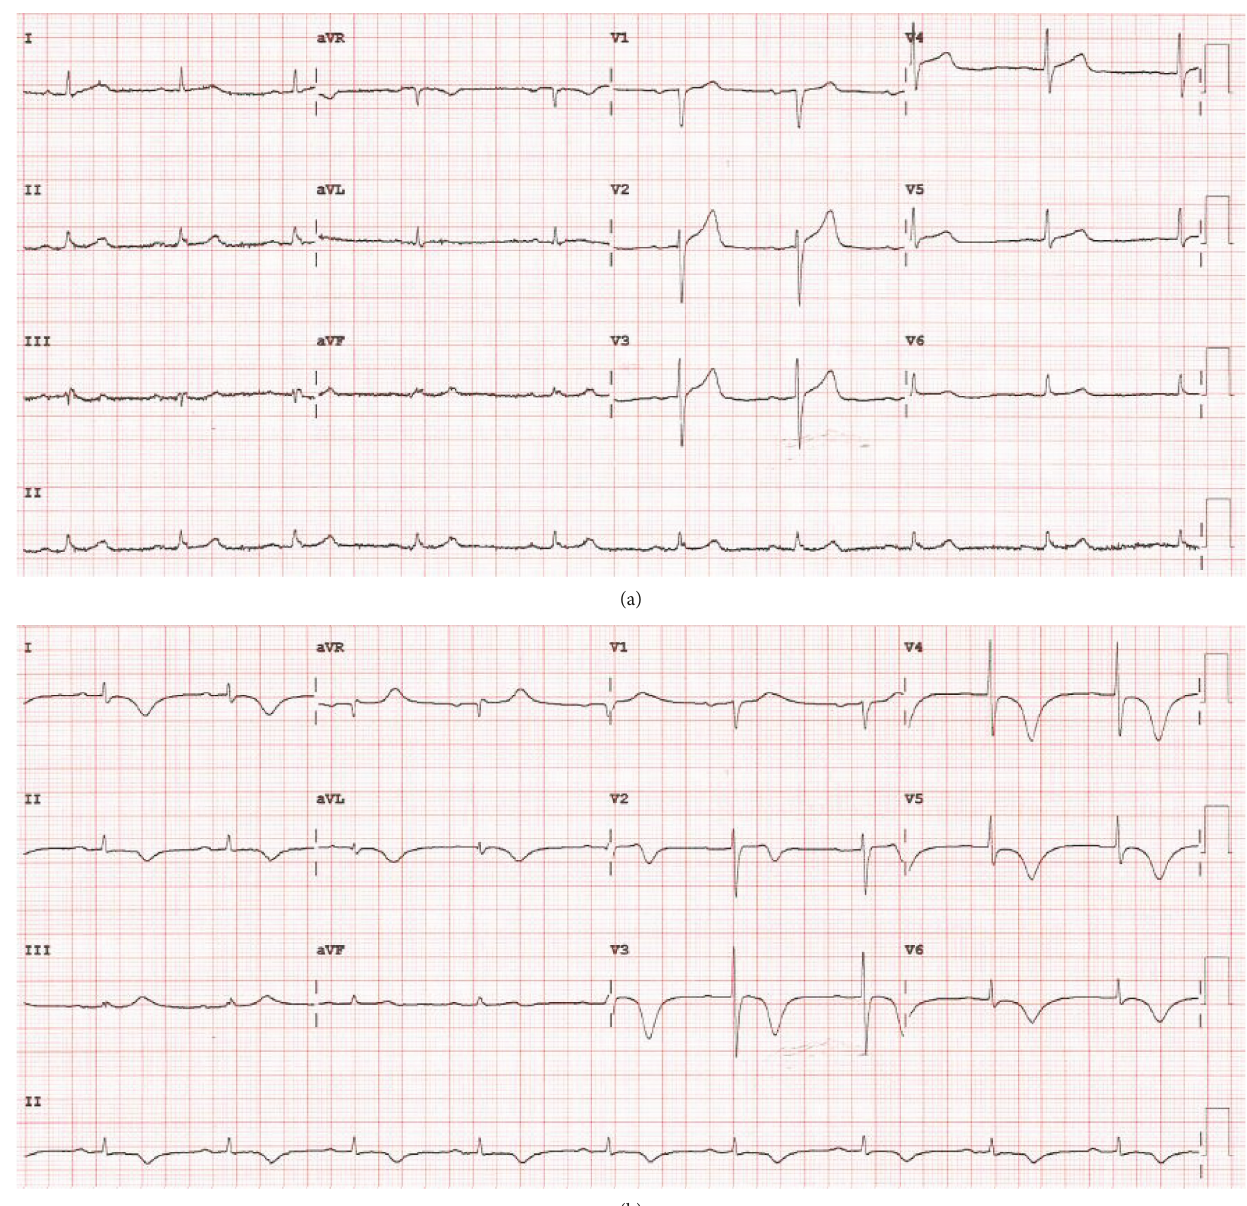
Figure 1: (a) Admission ECG showing minimal anterior ST elevation and concave ST segments in leads II, III, and aVF. (b) ECG 48 hours after presentation demonstrating deep T wave inversion across precordial and limb leads with a prolonged